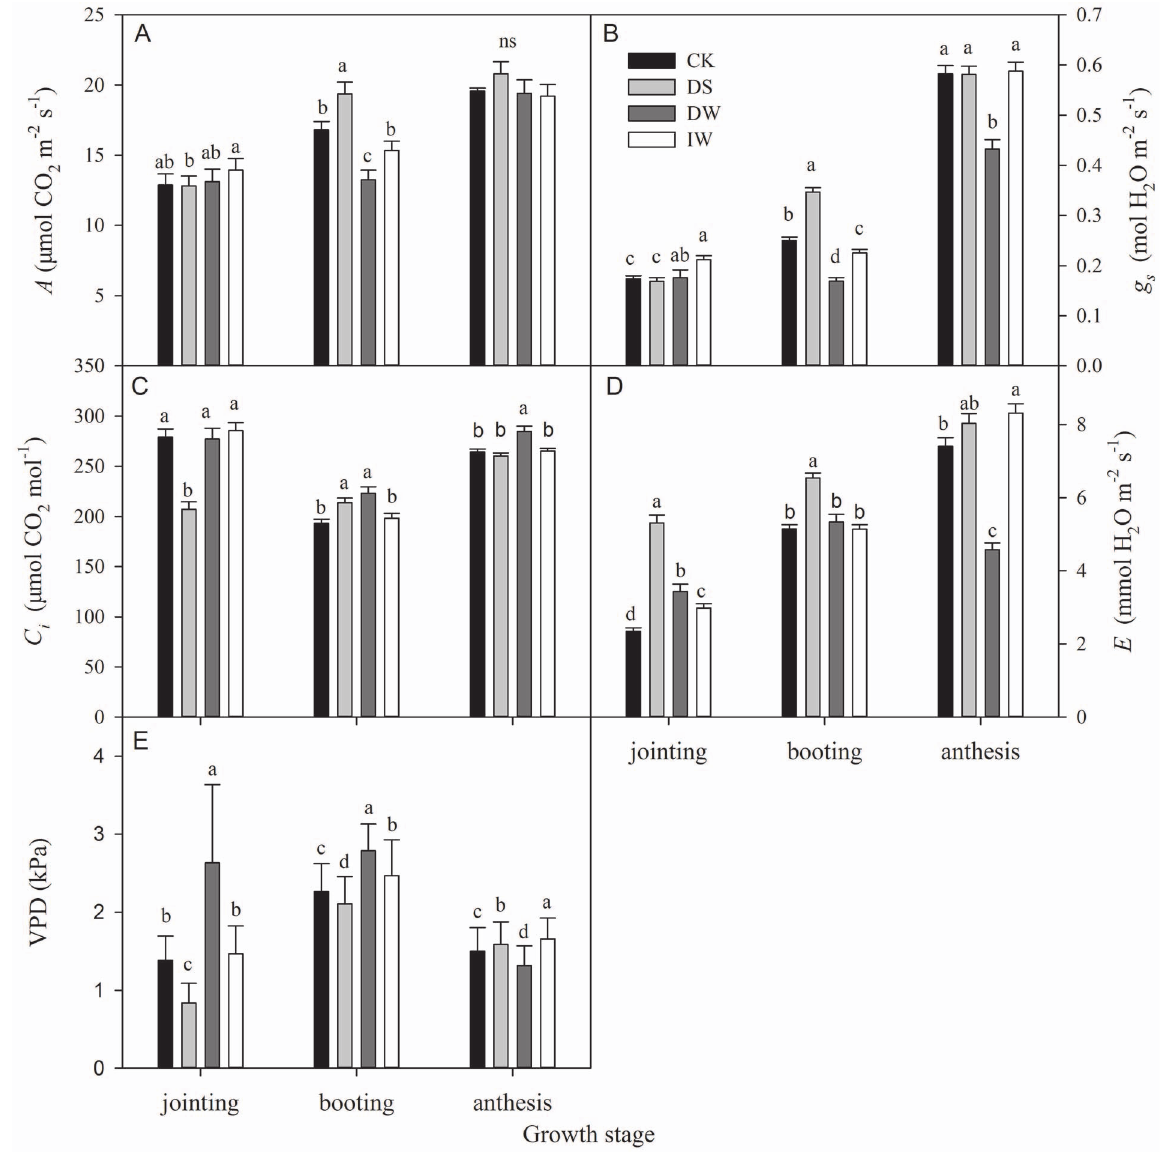
Figure 9. Seasonal changes in (A) assimilation rate ( A ), (B) stomatal conductance ( g s ), (C) intercellular CO 2 concentration ( C i ) (D) transpiration rate ( E ) and (E) atmospheric vapour pressure deficit (VPD) (mean ± SE) in winter wheat under four treatments (CK, DS, DW and IW), during growth stages. Significant differences ( P , 0.05) are indicated with different lower case letters.